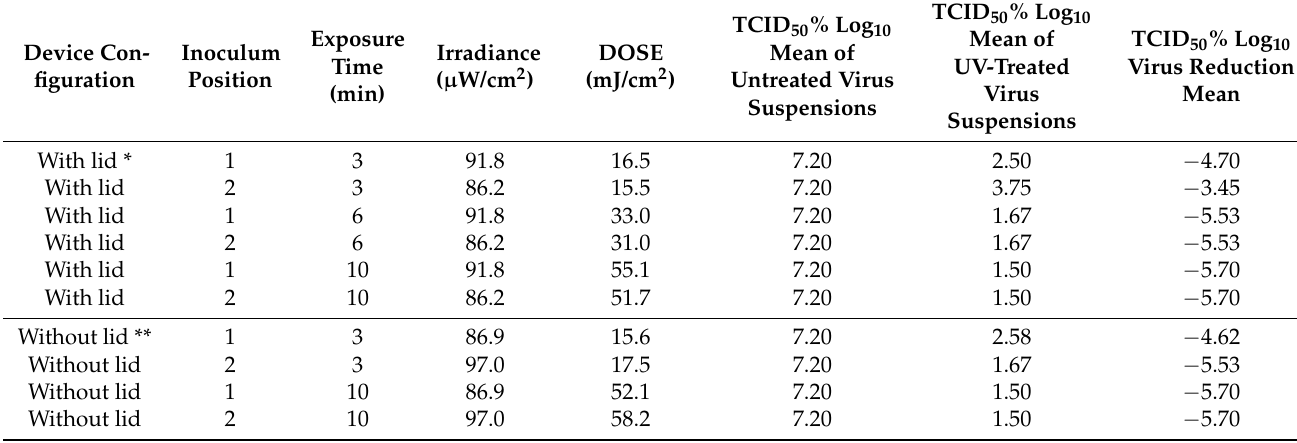
Table 2. Evaluation of the virucide activity on SARS-CoV-2.